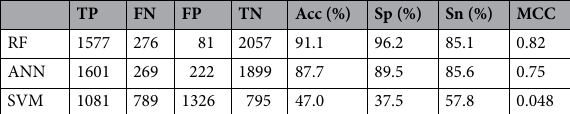
Table 4. Independent dataset testing results of all models.